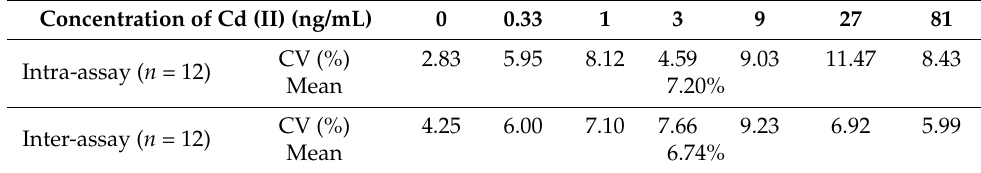
Table 4. Variation of intro- and inter-assay.